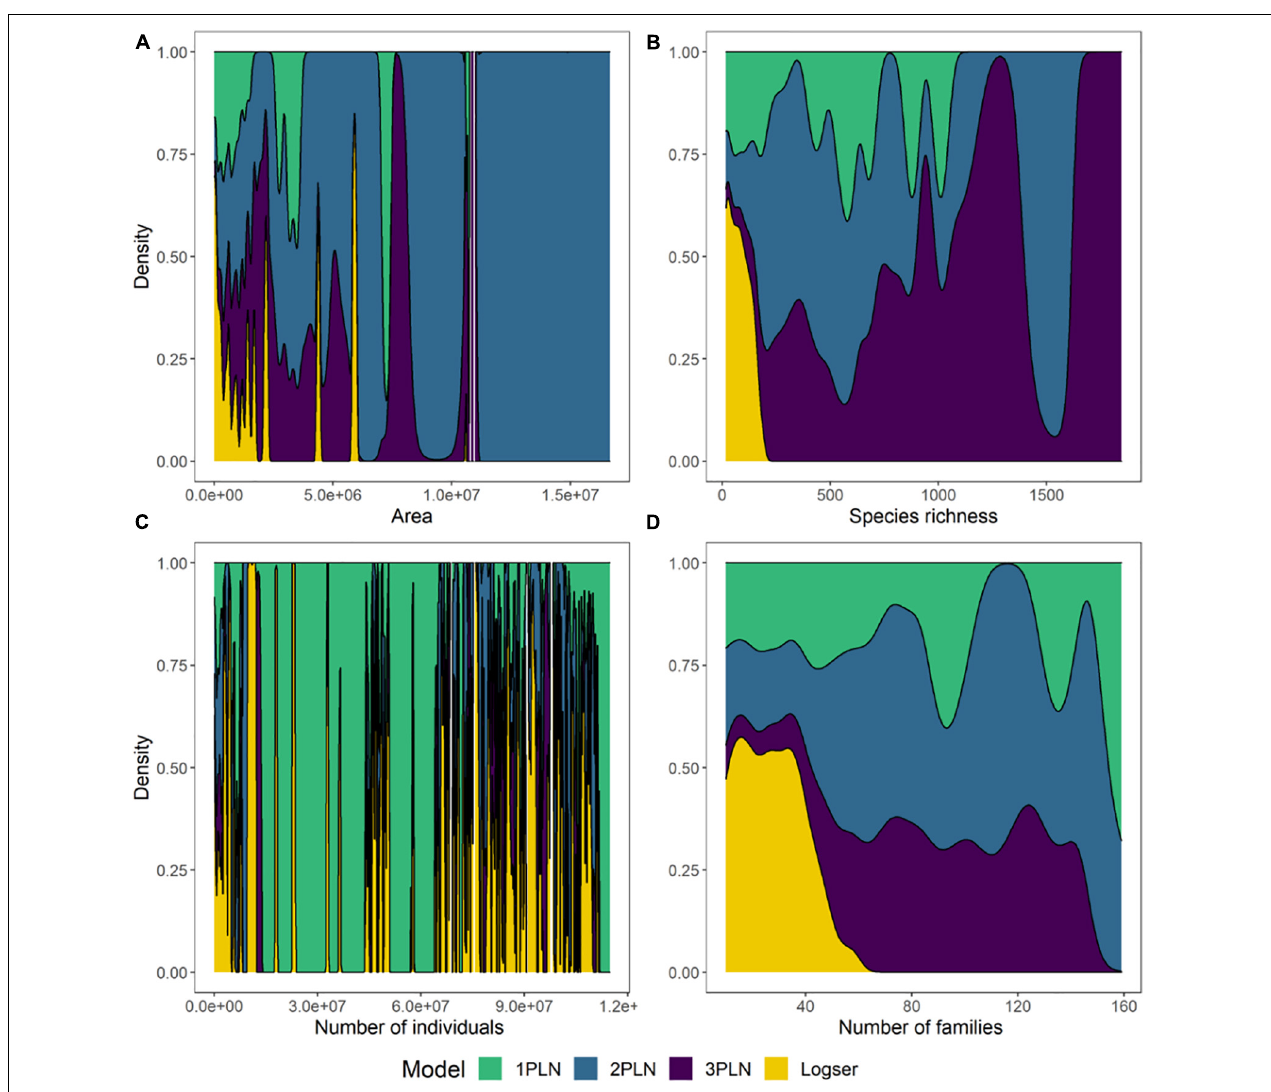
FIGURE 3 | Effect of area sampled (A) , species richness (B) , total number of individuals (C) , and number of families (D) on SAD shape (best model selected) aggregated across all the communities (see Supplementary Figure 1 for plots for each individual community). Plots were built using the function geom_density from the ggplot package in R (Wickham, 2009), which computes smoothed versions of histograms for continuous variables.